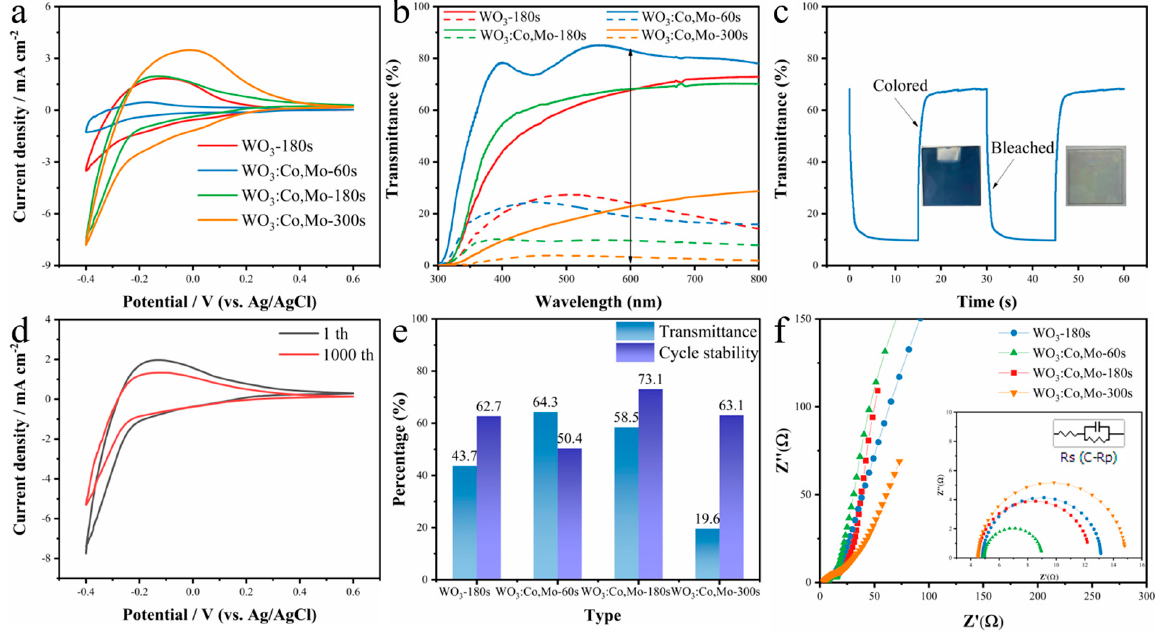
Figure 4. ( a ) CV curves of different films. ( b ) Transmittance spectra of different films. The solid line represents the bleached state, and the dotted line represents the colored state. ( c ) The switching time of WO 3 : Co, Mo -180s film at a wavelength of 600 nm, the illustration shows the colored and bleached state of the film. ( d ) The stability of WO 3 : Co, Mo -180s film. ( e ) The comparison between different films in transmittance modulation and cycle stability. ( f ) EIS of the different films.